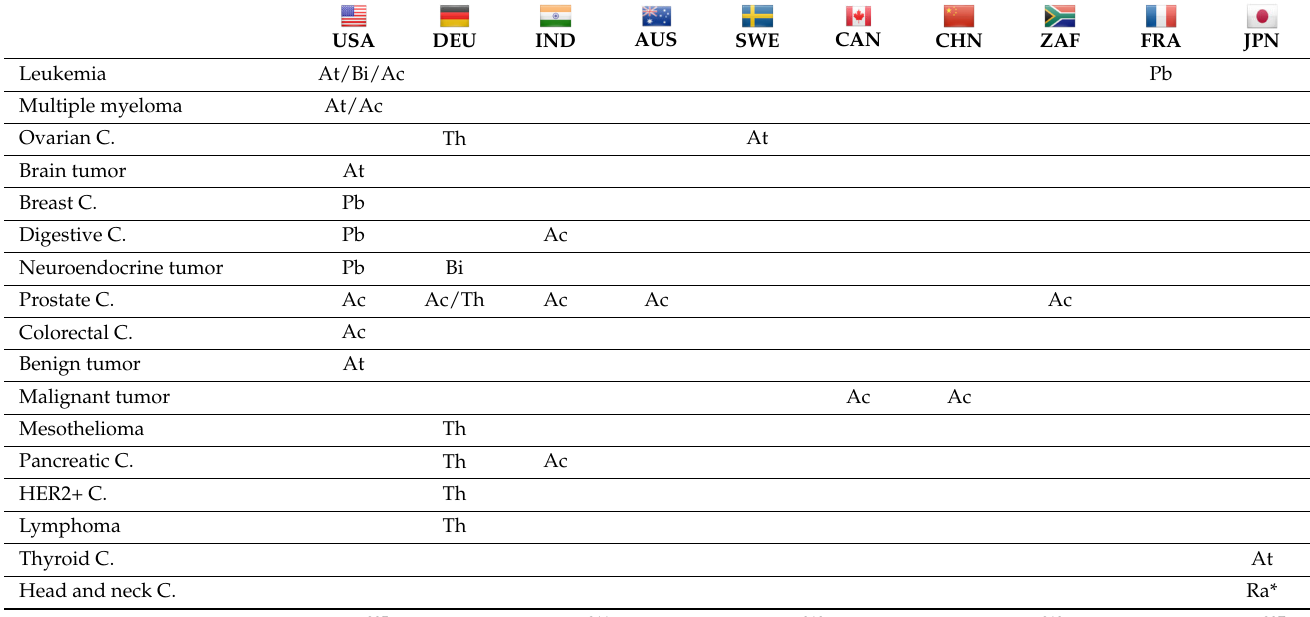
Table 2. Ongoing clinical trials (phases I and II) with alpha-emitters (March